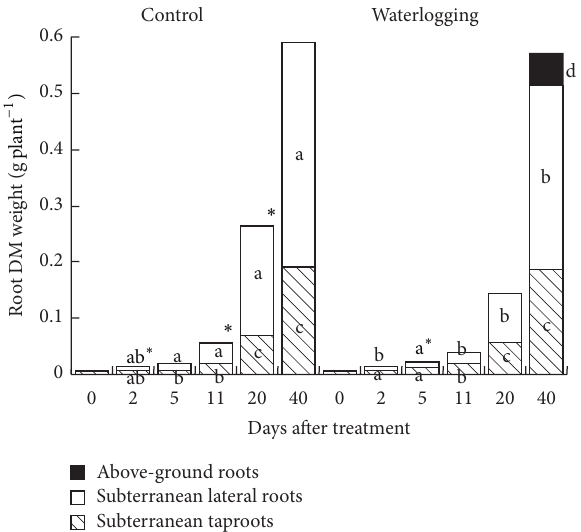
Figure 5: Changes in single nodule DM weight in experiment 2. ∗ Symbols with different letters at each sampling day are significantly different at 𝑃 < 0.05 ; ns: not significant. Error bars give ± one SE ( 𝑛 = 3